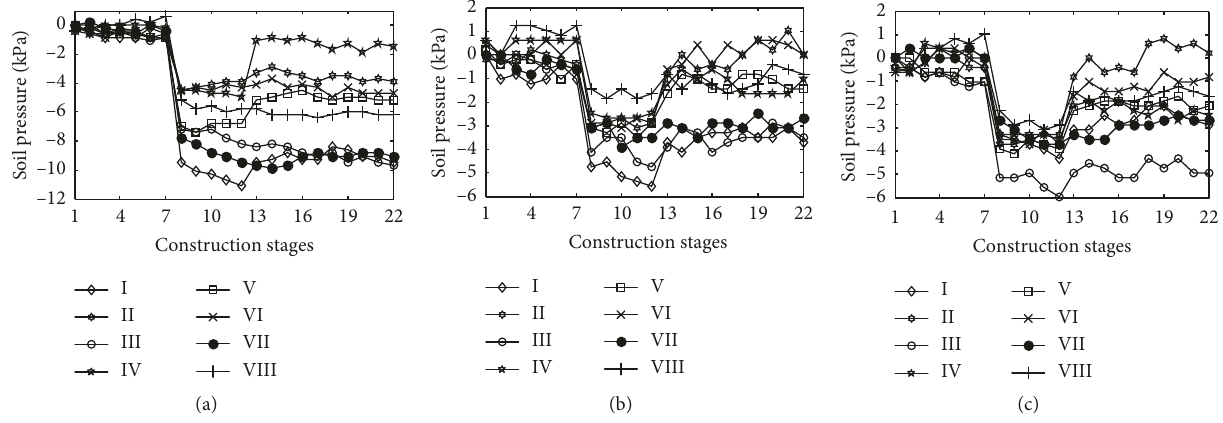
Figure 16: Comparison of soil pressure below the excavation: (a) 112; (b) 118; (c) 122.